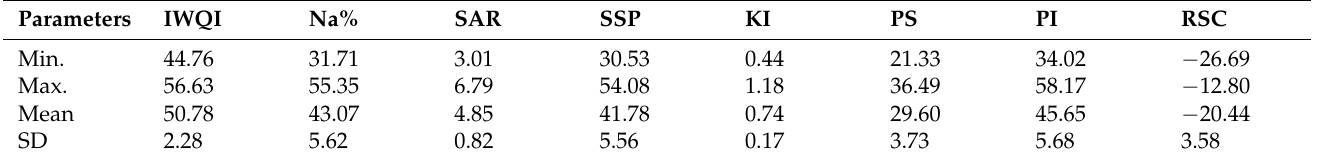
Table 4. Statistical analysis of the IWQIs values.